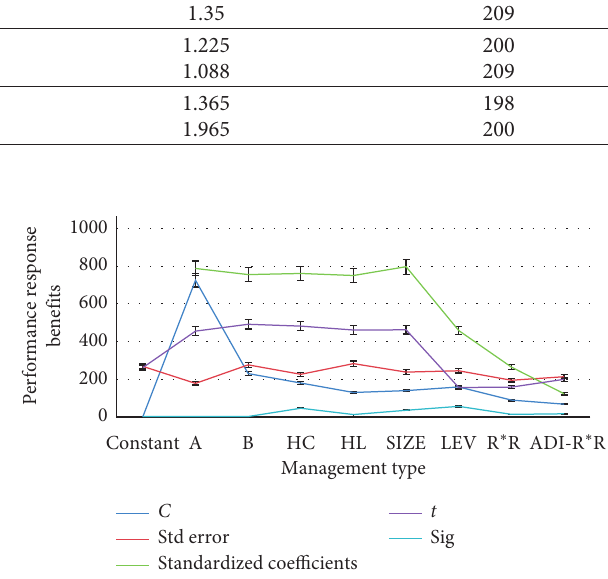
Figure 3: Regression analysis of human capital investment and enterprise